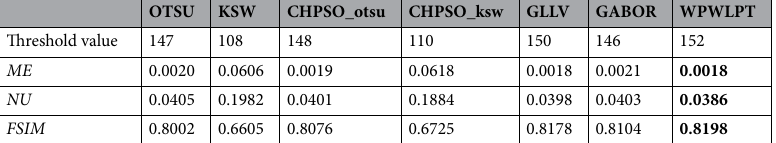
Table 2. The threshold values, MEs , NUs and FSIMs of the seven thresholding methods on the synthetic “Squares” image. The best results are highlighted in